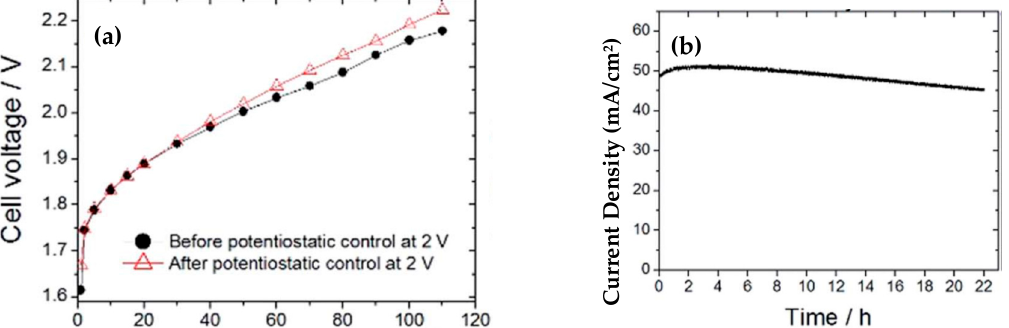
Figure 20. ( a ) PEM WE polarization curves before and after 22 h of potentiostatic control at 2 V. ( b ) Stability run at 2 V for 22 h. Reprinted with permission from [213]. Copyright 2018 The Royal Society of Chemistry.